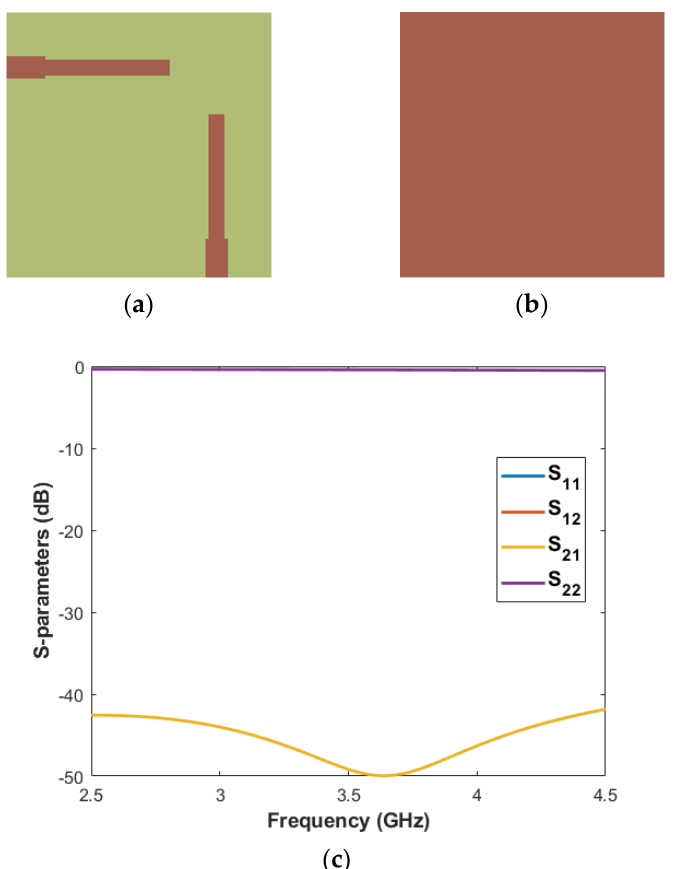
Figure 2. First step in antenna design: ( a ) top view, ( b ) bottom view, and ( c ) corresponding S-parameters results.